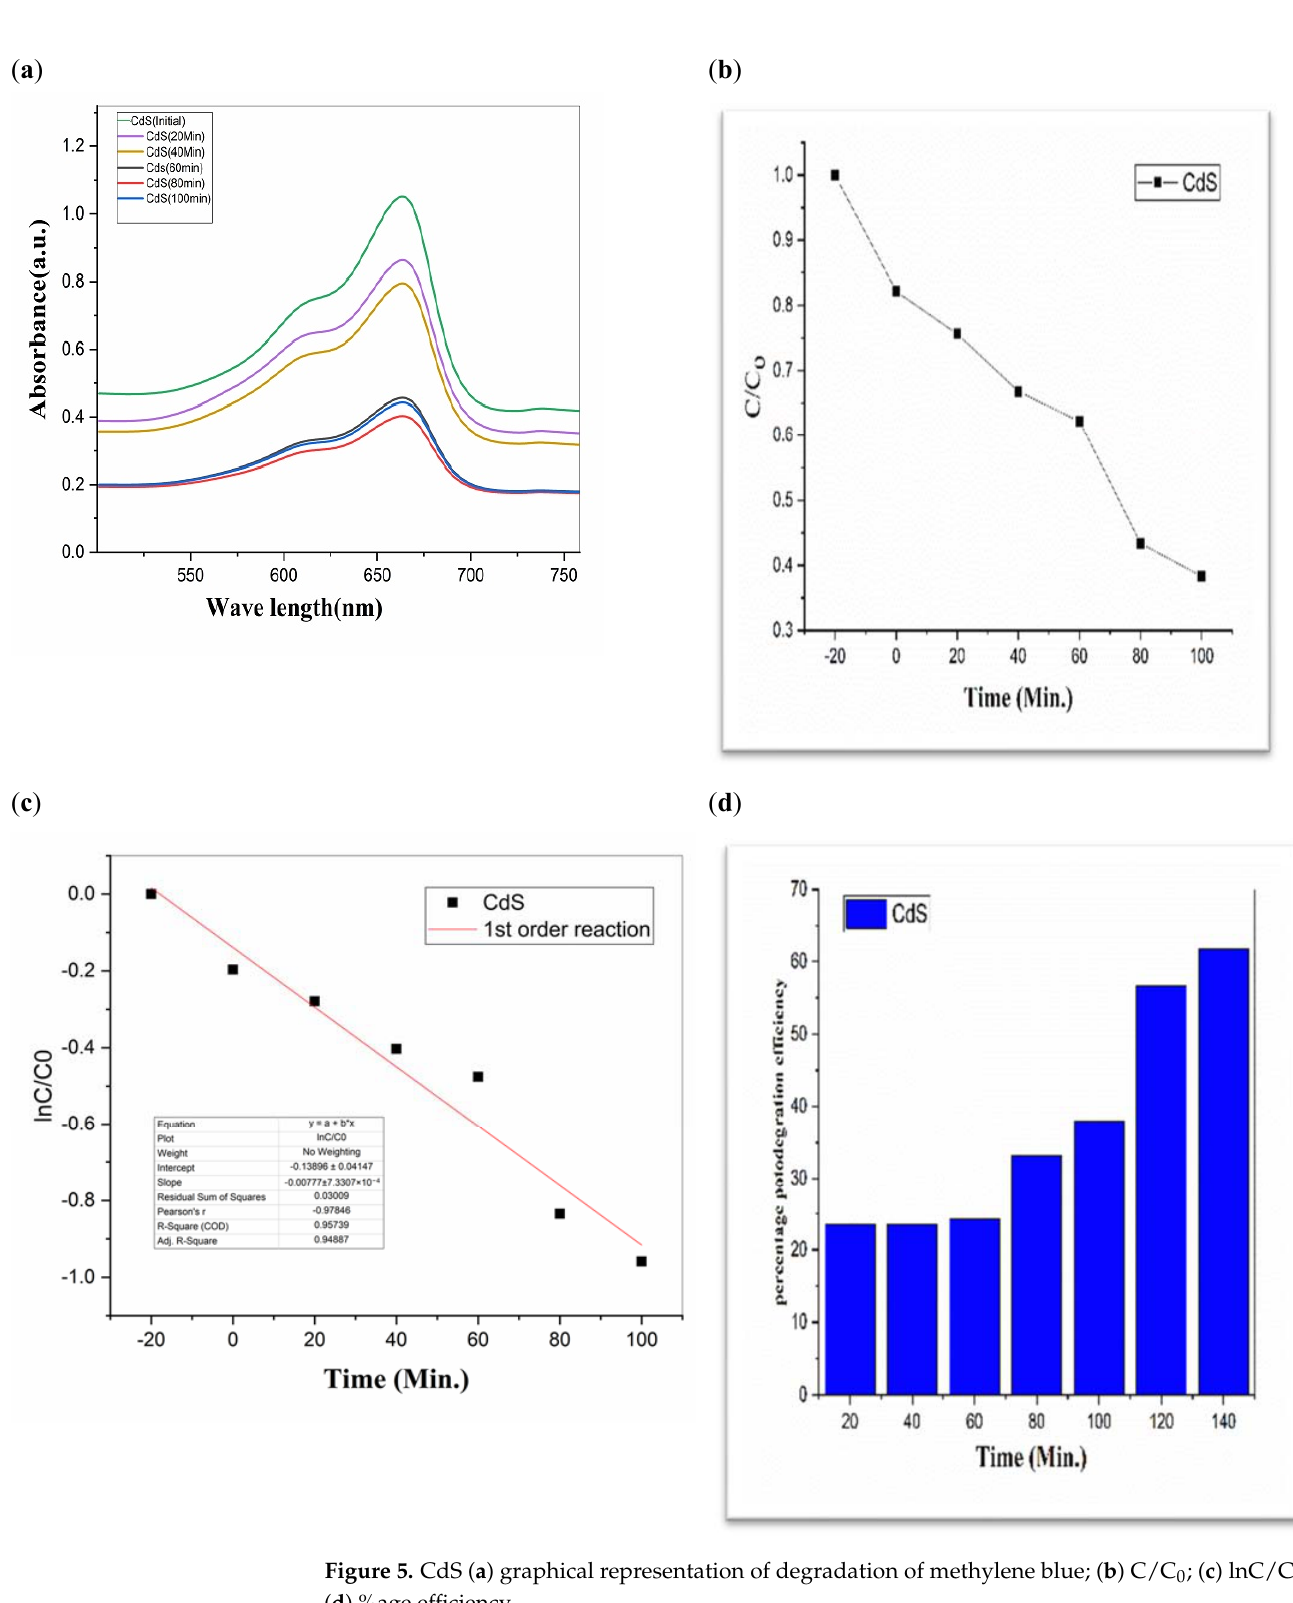
Figure 5. CdS ( a ) graphical representation of degradation of methylene blue; ( b ) C/C 0 ; ( c ) lnC/C 0 ; ( d ) %age e ffi ciency.